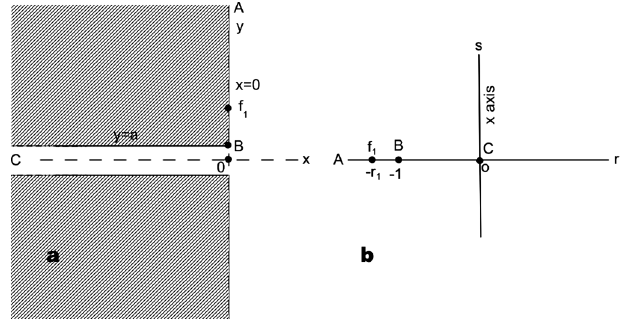
FIG. 1. Conformal mapping of one side of a semi-infinite dipole magnet to the upper half of the t plane. (a) Pole pieces in the z plane. (b) Image of pole pieces and x axis in t plane. f 1 indicates the position of a current filament on the pole